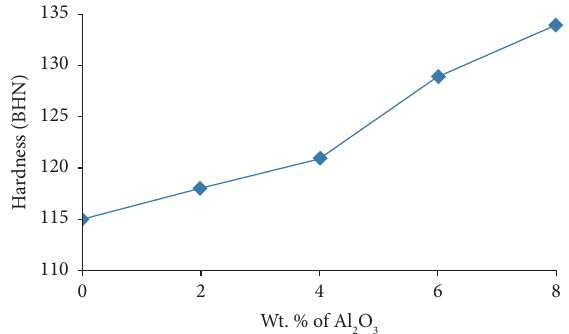
Figure 5: Hardness of Al 7075 MMC with/Al